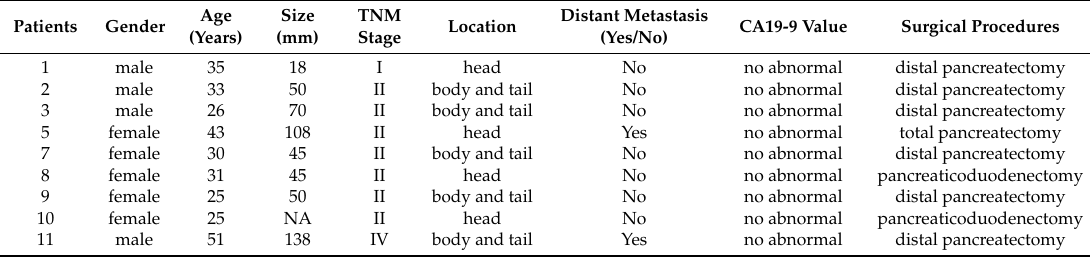
Table 1. Clinicopathological characteristics of patients.